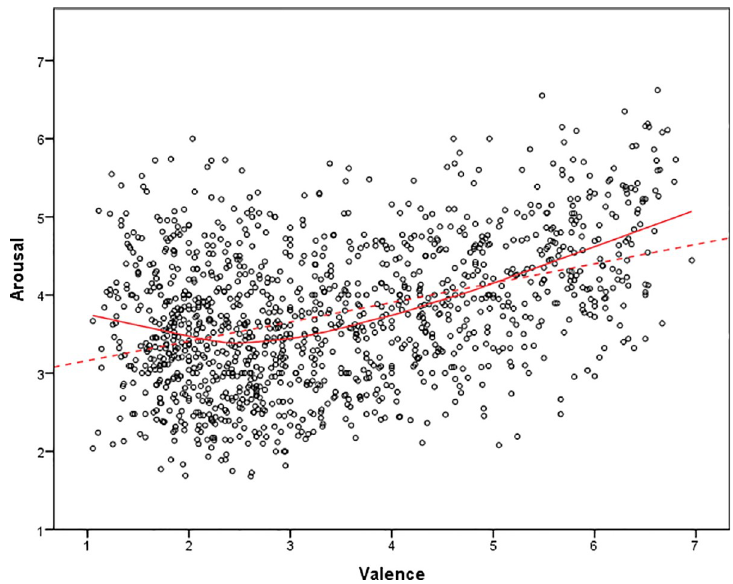
Fig 1. Valence ratings plotted against arousal ratings. Each dot represents the mean for each word across participants.